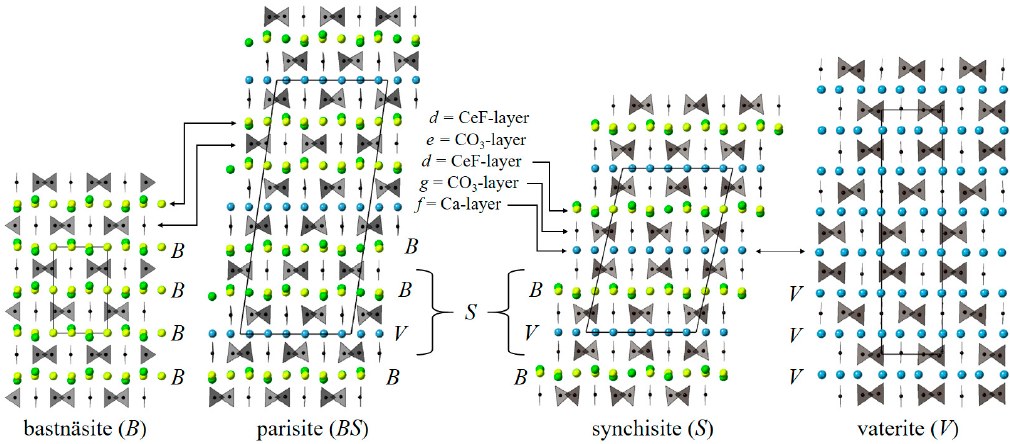
Figure 1. Structures of bastnäsite-(Ce) [19], synchysite-(Ce) [17], parisite-(Ce) [18] and vaterite [20], all as seen along [010]. Yellow = Ce, blue = Ca, green = F, black = C. Oxygen atoms at the vertices of triangular CO 3 groups are omitted for clarity. Analogous layers in the different structures are connected by arrows and indicated with their relative codes.